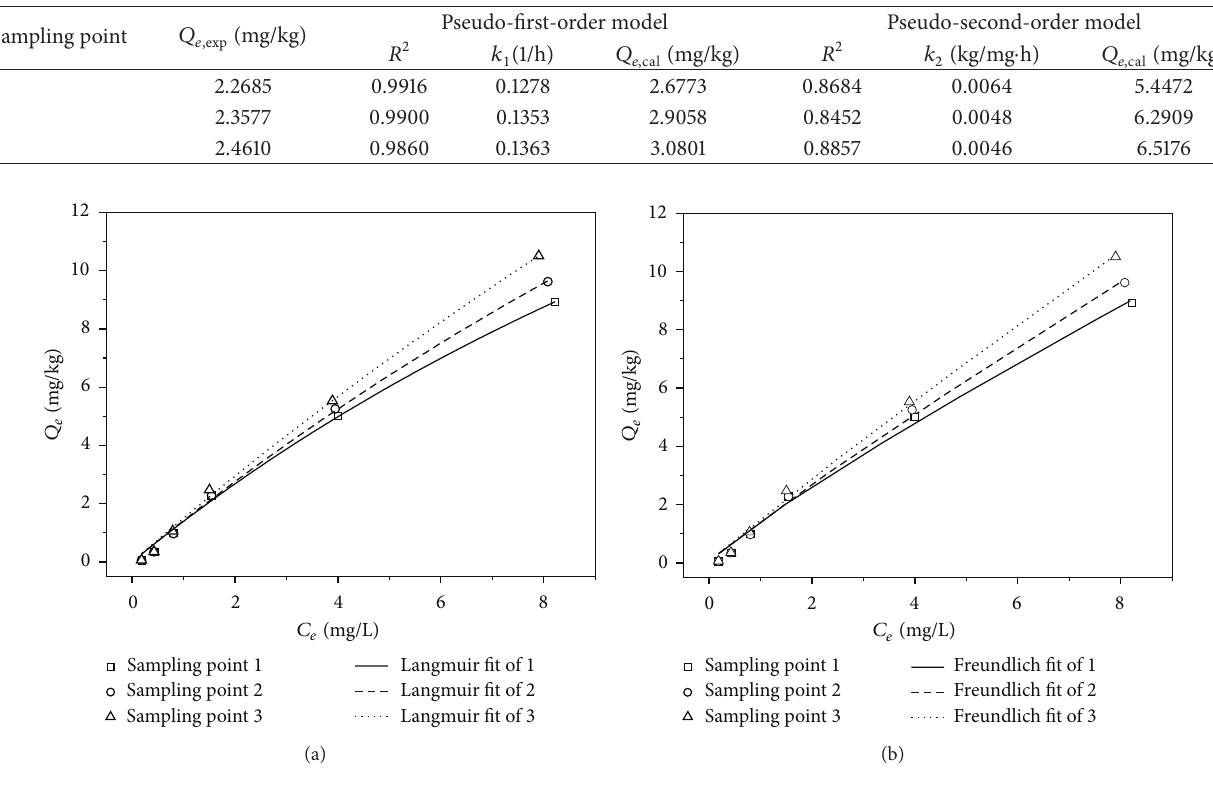
Figure 6: Two-parameter isotherm models (Langmuir and Freundlich) fit of adsorption